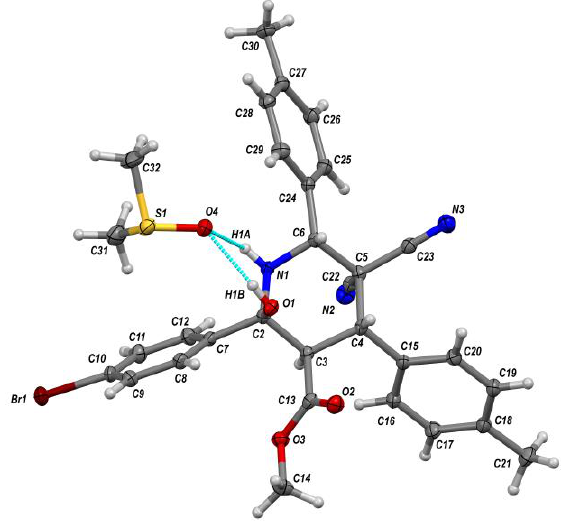
Figure 3. X-Ray structure of the 6d (2 SR ,3 RS ,4 SR ,6 RS ) configuration. Hydrogen bonding between the molecules of 6d and DMSO.